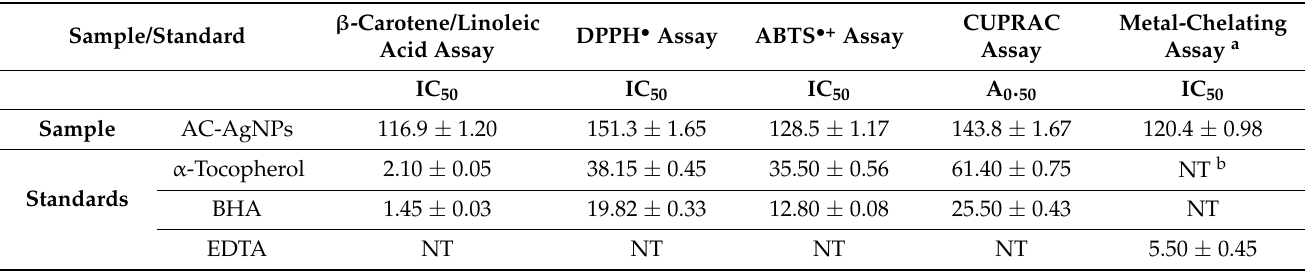
Table 2. Antioxidant activity of AC-AgNPs as determined by DPPH • , ABTS • , CUPRAC, and metal- chelating assays ( µ g/mL).